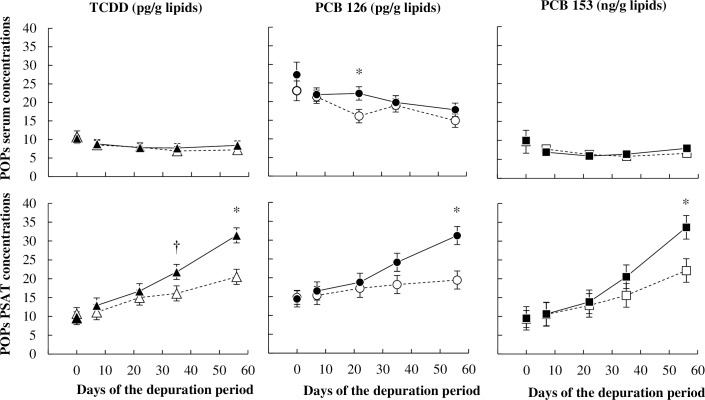
Time pattern kinetics of pollutants concentrations in serum and pericaudal subcutaneous adipose tissue (PSAT) of ewes receiving a control well-fed and non-supplemented treatment (CTL: Δ, ○, □) or an underfed and mineral oil supplemented treatment (UFMO: ▲, ●, ■).Each point represents the least-squares mean, and error bars indicate SEM except at day 0, for which they represent the mean and SE. The * symbol indicates a significant (P ≤ 0.05) and † a tendency toward significance (P ≤ 0.10) for treatment effect on the considered day.